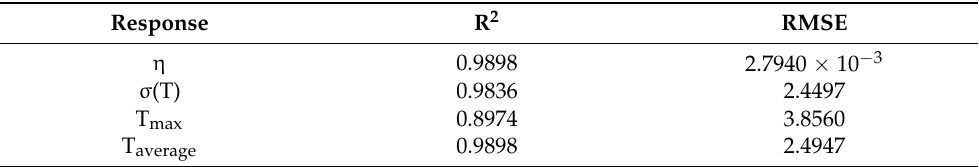
Table 4. Reliability index for approximate models (adapted with permission from [16]; copyright 2021 Korean Society for Fluid Machinery).